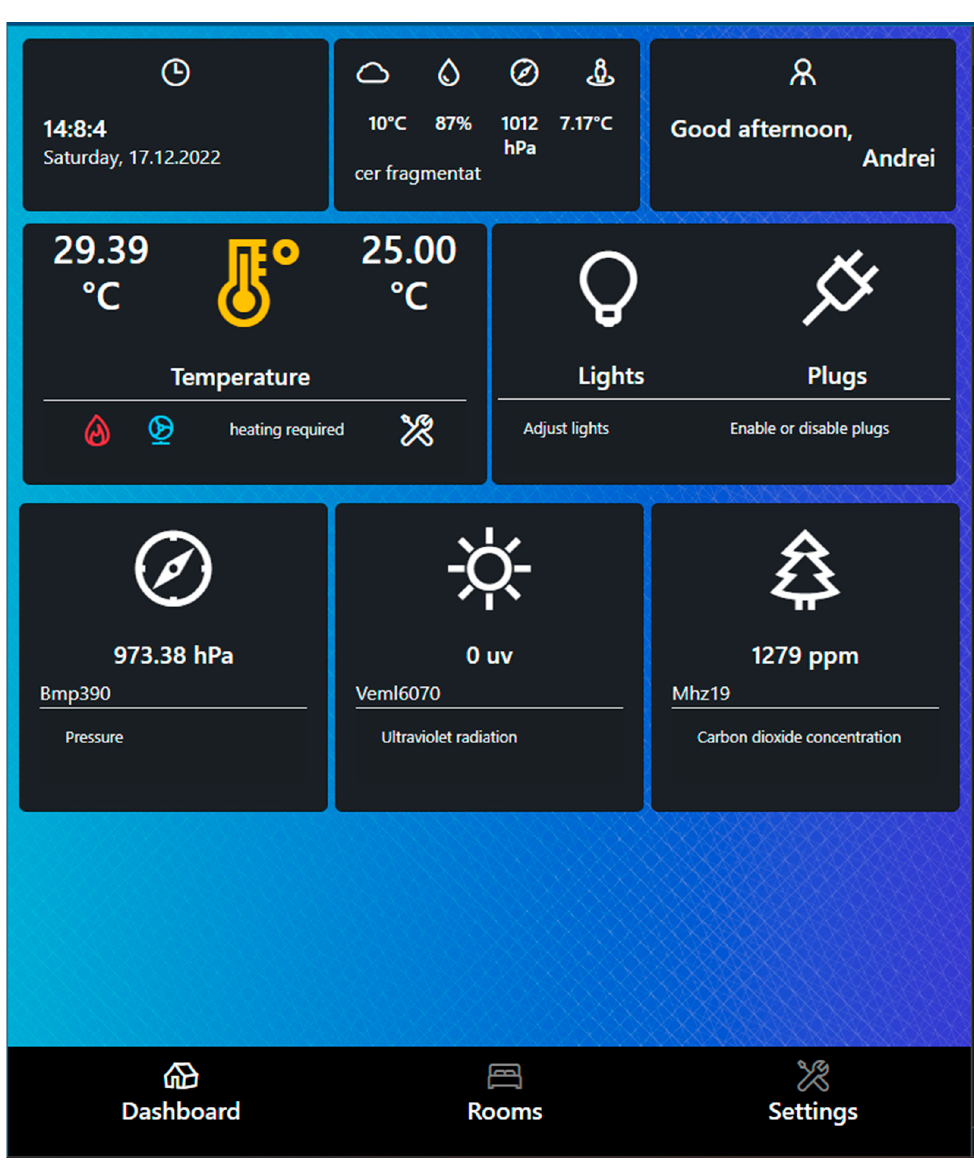
Figure 7. Main frontend screen.